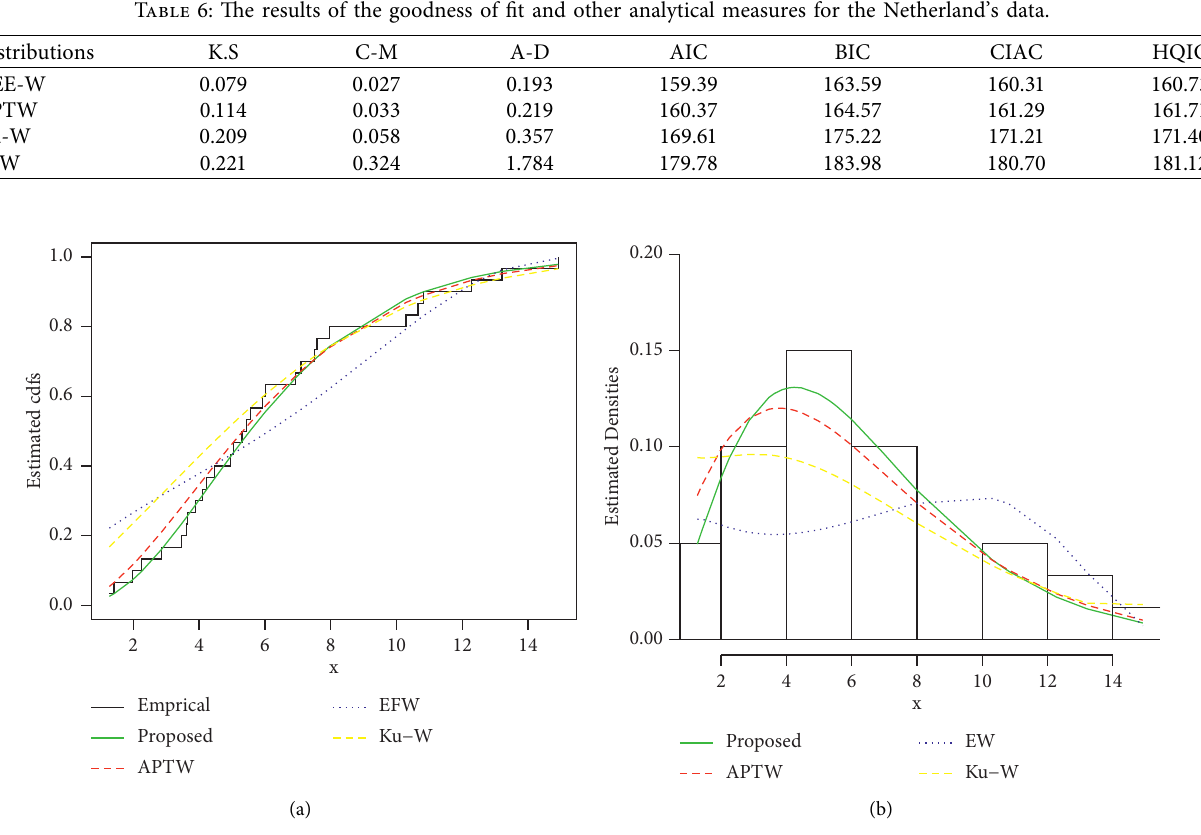
Figure 7: Fitted plots of joint CDF and pdf for proposed and competing models using COVID-19 data collected in the